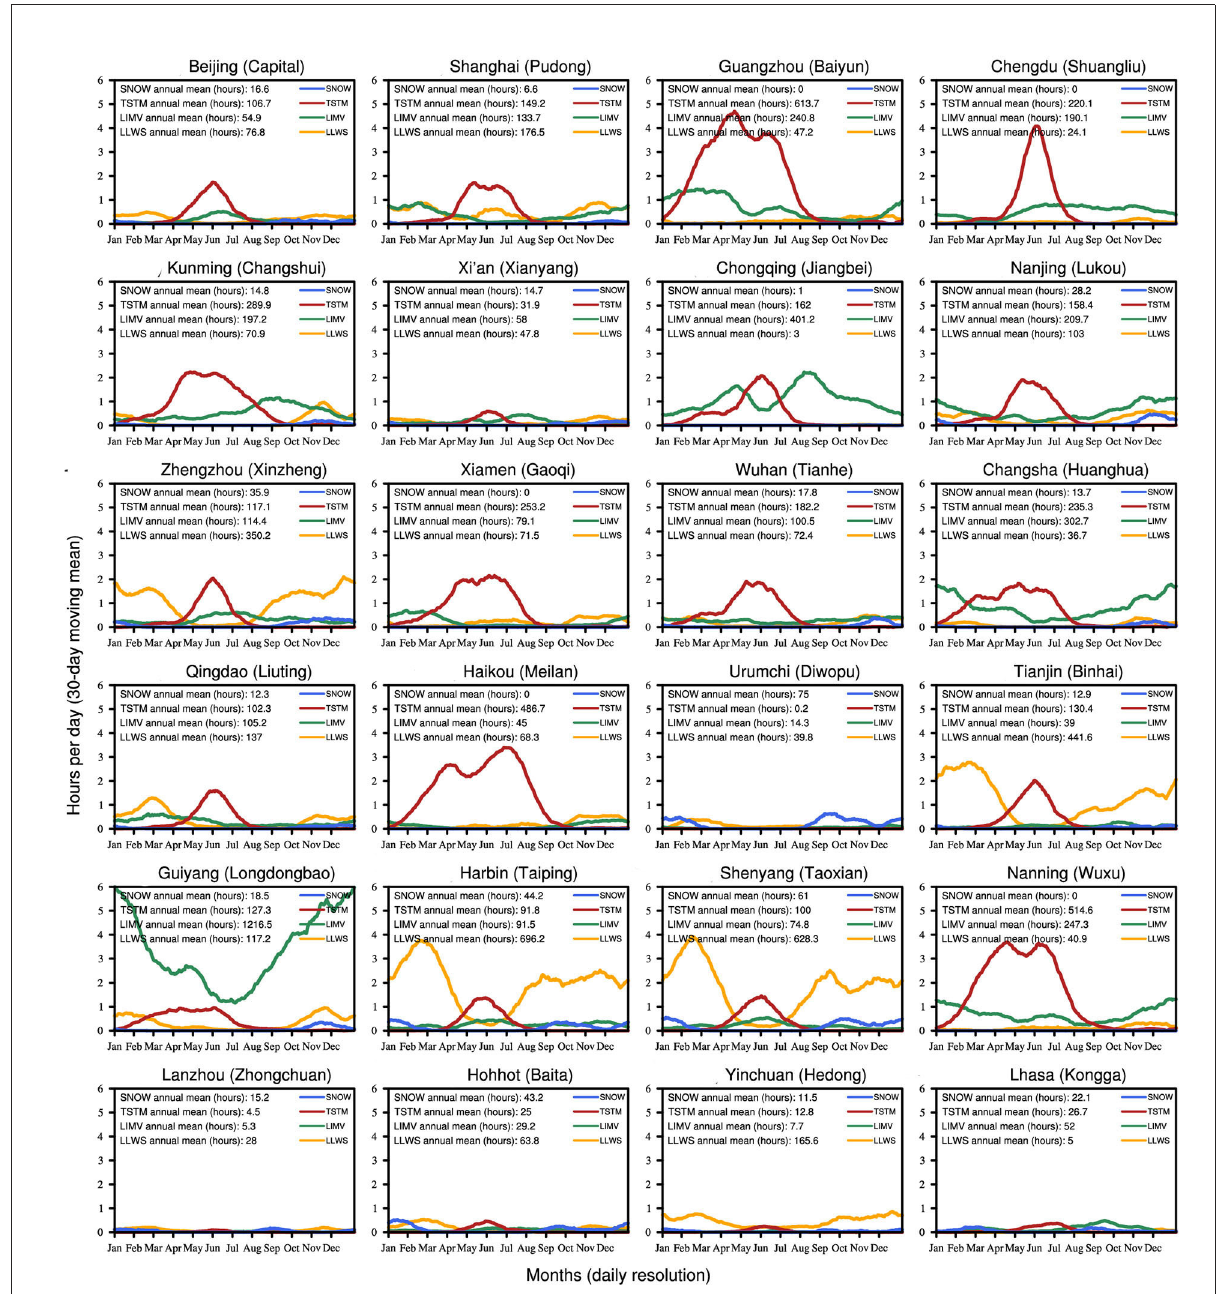
FIGURE7 Annual cycles for the numbers of hours with LLWS (orange), LIMV (green), TSTM (red), and SNOW (blue) over selected airports (Figure 1).